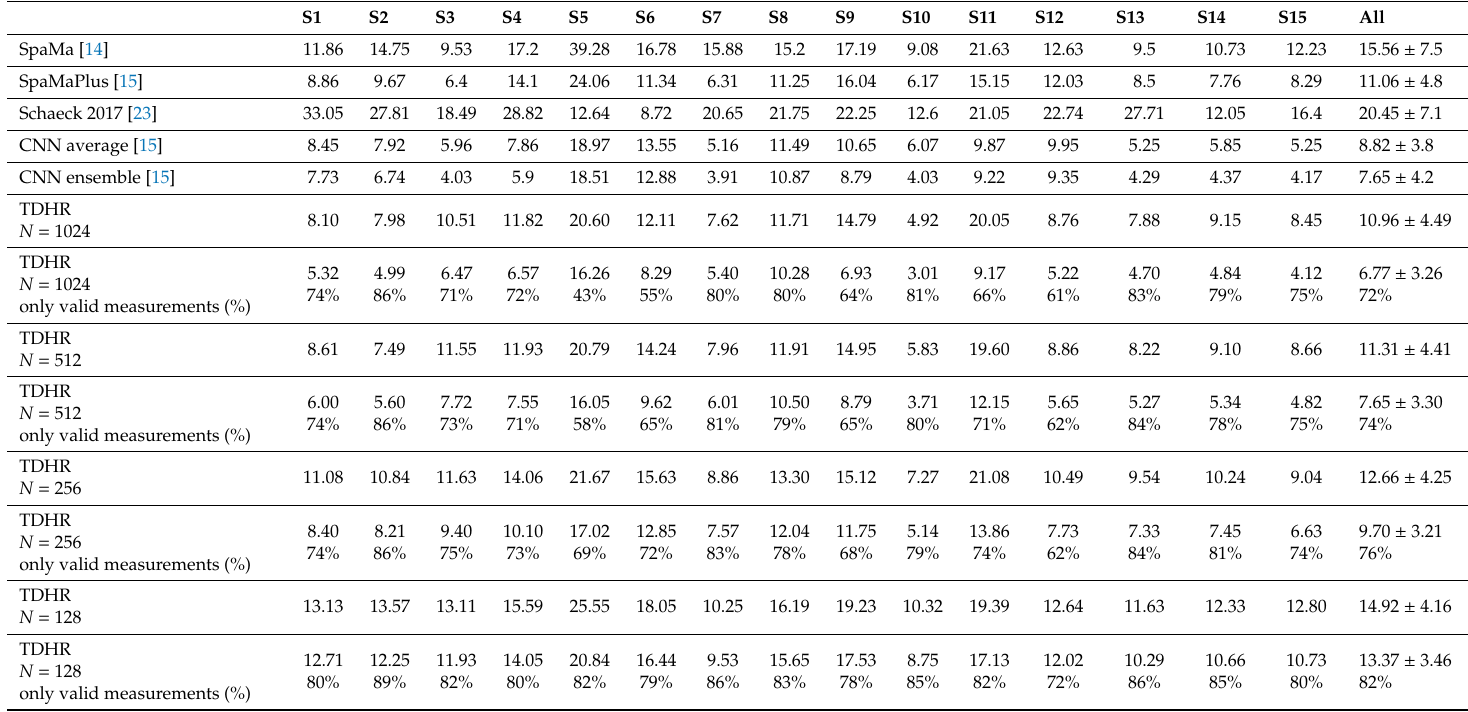
Table 1. Comparison of the accuracy of the presented algorithm to the algorithms from the literature on the large PPG-DaLia dataset as MAE (bpm). The proposed TDHR algorithm was tested in several versions, with various numbers of analyzed samples N (for all other algorithms N = 256), sampled with a frequency of 32 Hz, with a BPM min = 40 bpm. The measurements were done every 2 s. For the TDHR algorithm, the accuracy was also calculated for valid measurements, and then the percentage of valid measurements was also